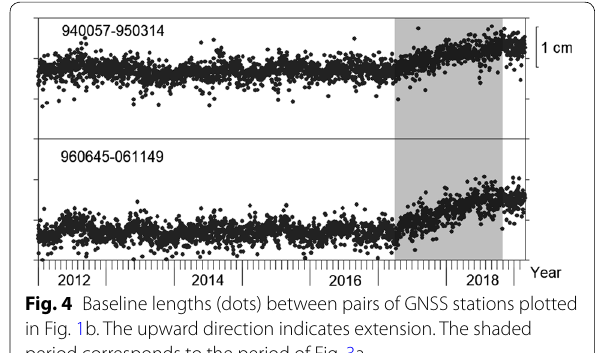
Fig. 4 Baseline lengths (dots) between pairs of GNSS stations plotted in Fig. 1b. The upward direction indicates extension. The shaded period corresponds to the period of Fig.